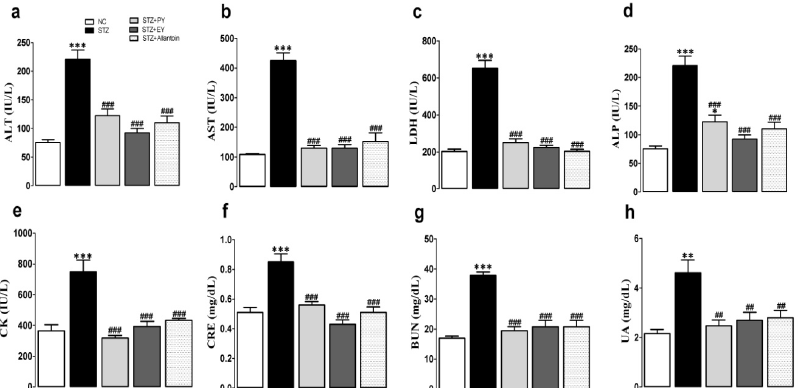
Figure 3. Effects of PY, EY, and allantoin treatments on the serum levels of metabolic enzymes, BUN, CRE, and UA in STZ ‐ induced diabetic rats. ALT, alanine aminotransaminase (a); AST, aspartate aminotransferase (b); LDH, lactate dehydrogenase (c); ALP, alkaline phosphatase (d); CK, creatinine kinase (e); CRE, creatinine (f); BUN, blood urea nitrogen (g); UA, uric acid (h). Data are reported as means ± SEMs ( n = 10). *: p < 0.05; **: p < 0.01; and ***: p < 0.001, Bonferroni post hoc test following one ‐ way ANOVA versus the NC group (Cont); # : p < 0.05; ## : p < 0.01; and ### : p < 0.001, Bonferroni post hoc test following one ‐ way ANOVA versus the diabetic control group (STZ).